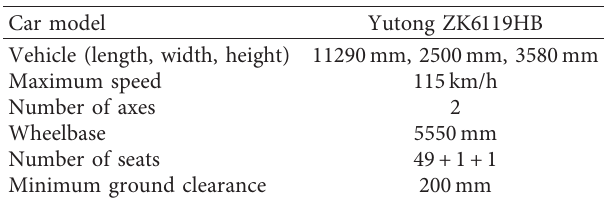
Figure 3: Testing vehicle (Yutong ZK6119HB). Table 2: Basic